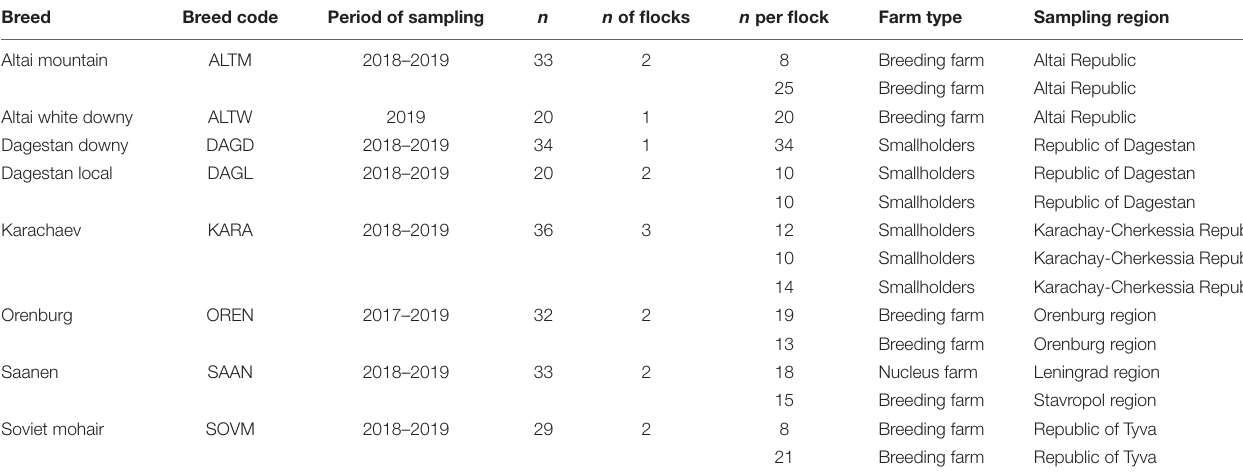
TABLE 1 | Sample collection of goats for this study.